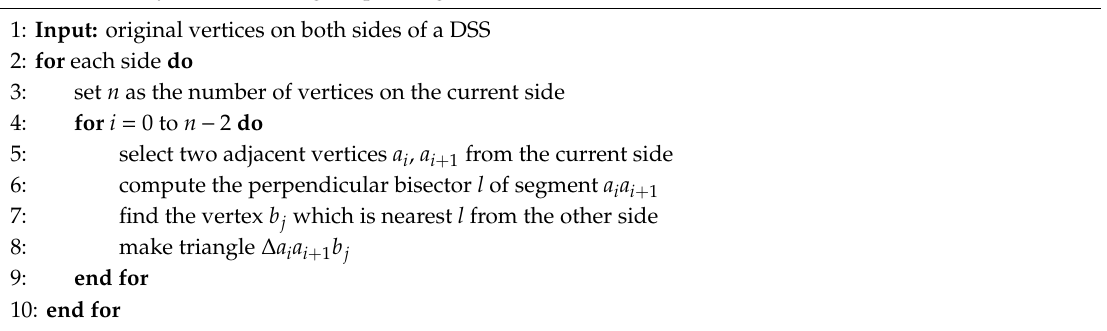
Algorithm 1 Dynamic Stitching Strip